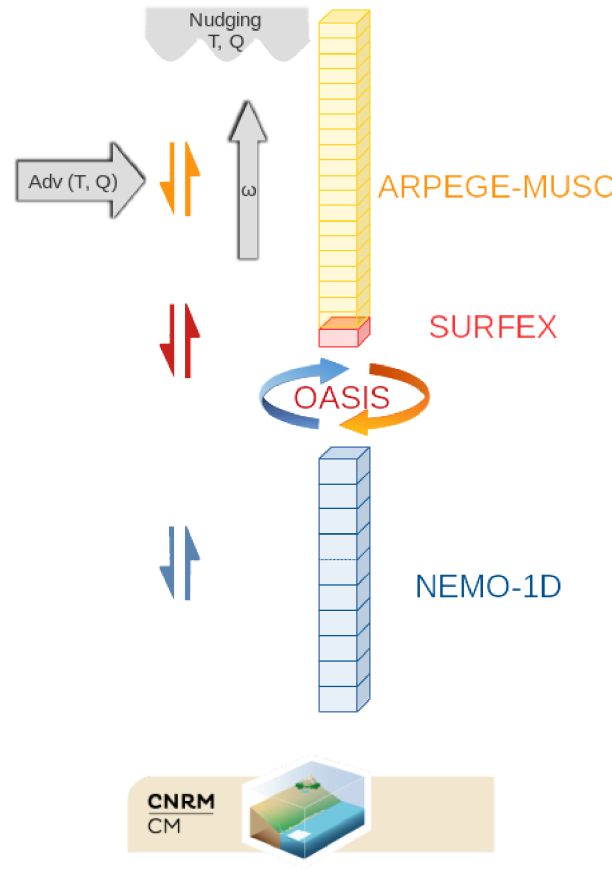
Figure 1. Schematic of the CNRM-CM6-1D uni-column coupled model. The grey elements picture imposed large-scale forcings. ω stands for the vertical velocity in pressure